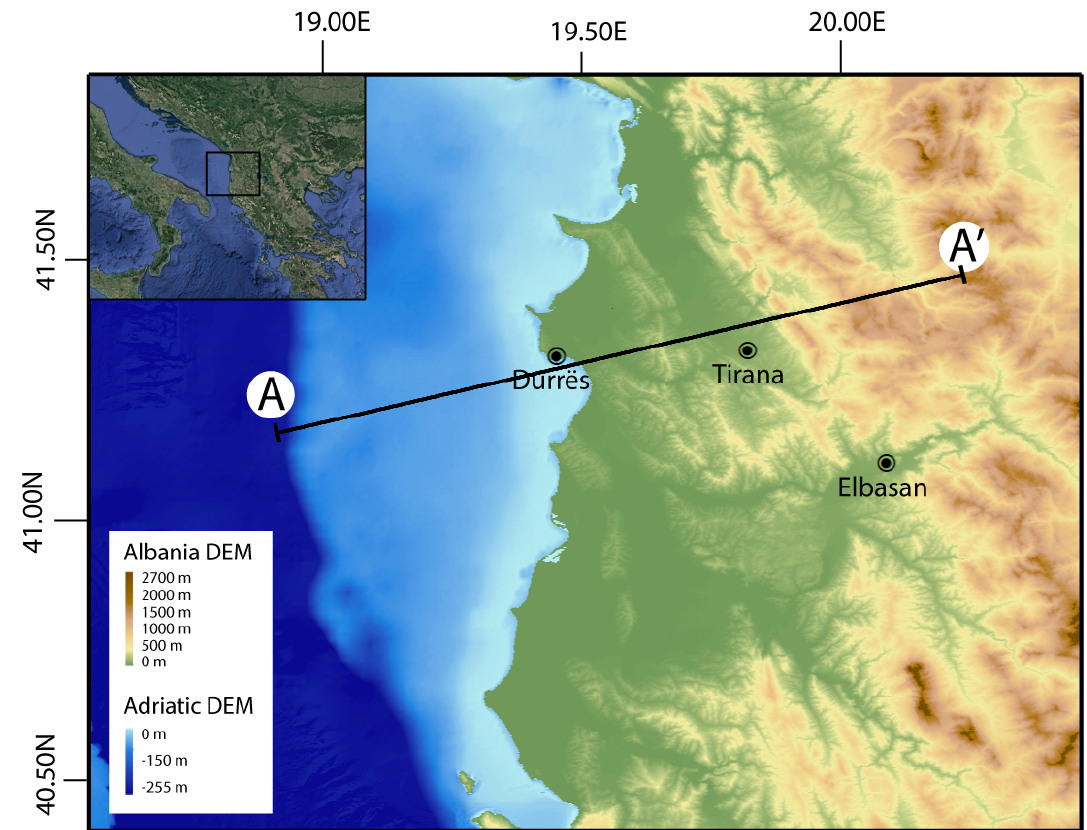
Figure 1. Digital Elevation Models (DEM) of the study area. The black line A-A’ shows the trace of the regional geological cross-section constructed in this study. The topography shown in this diagram is used in the analytical procedure for the calculation of the geotherms along vertical pseudo-wells (see text).